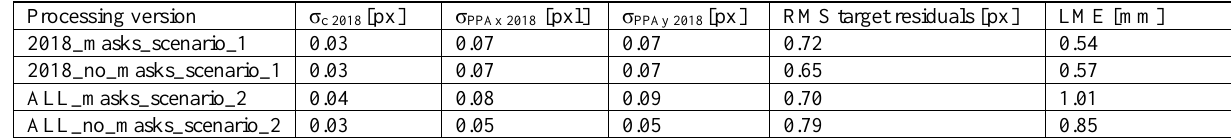
Table 3 . Synthesis of the relative comparison between dataset processing with and without masking from semantic